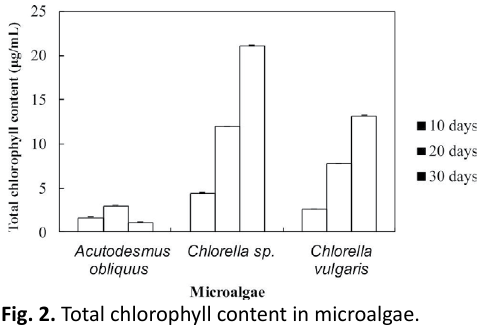
Fig. 2. Total chlorophyll content in microalgae.